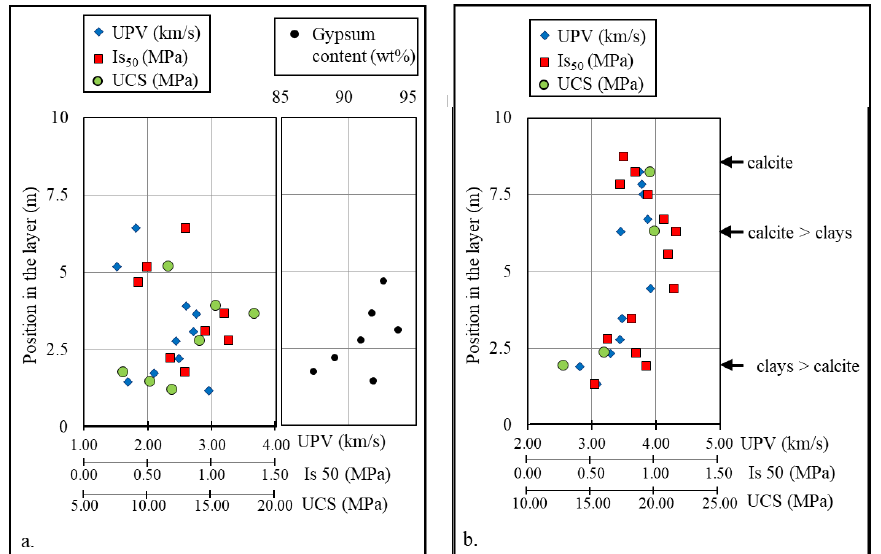
Figure 8. ( a ) Distribution of mechanical and physical parameters (left panel; from [16]) and gypsum content (right panel; from this study) in the S58 borehole. ( b ) Distribution of mechanical and physical parameters in the S61 borehole (from [16]) and position of chemical–mineralogical analyses reported in Figure 5. In the Figure, blue diamonds are the UPV, red squares are the strength index from PLT and green circles are the UCS.